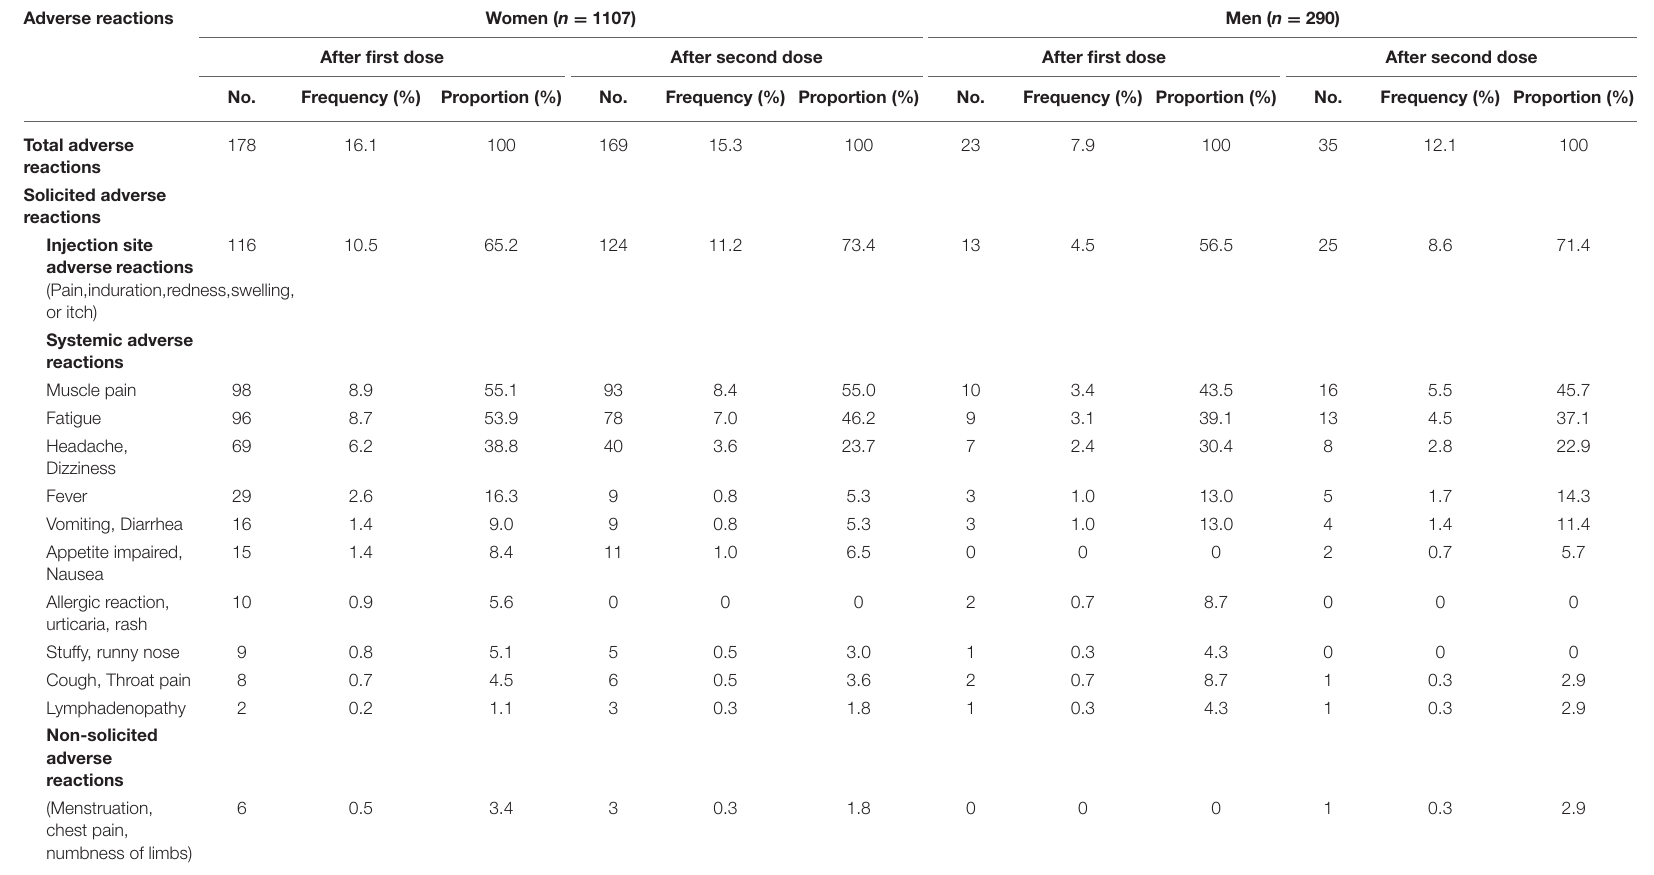
TABLE 1 | Distribution of multiple types of adverse reactions after vaccination in women and men. Adverse